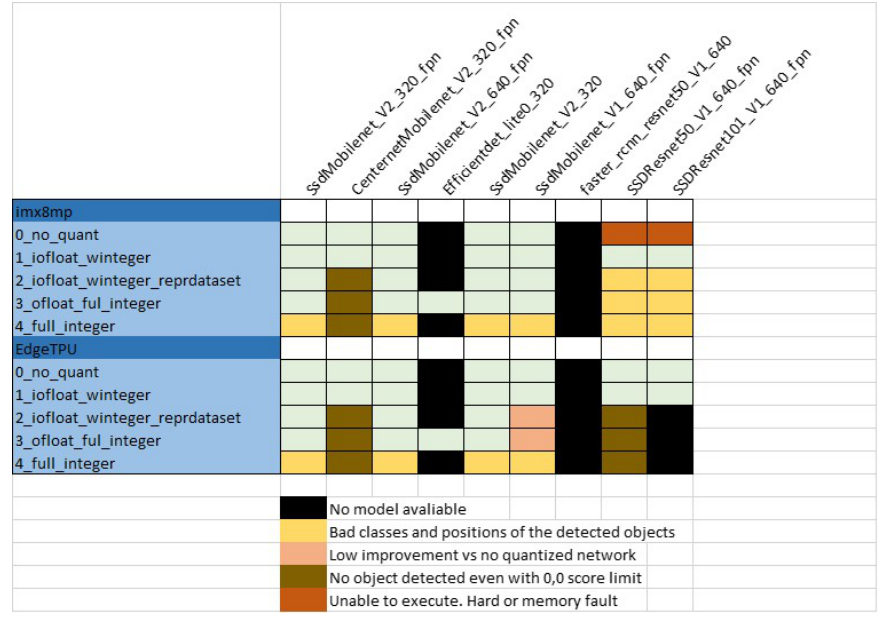
Figure 10. Inference issues.